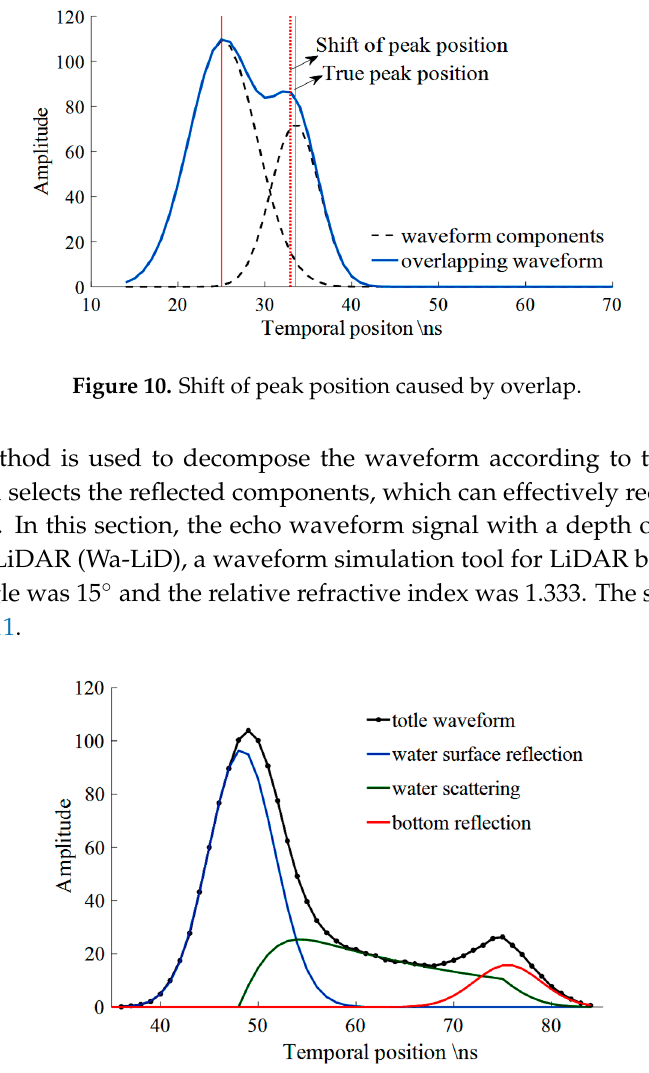
Figure 9. Component position selection.